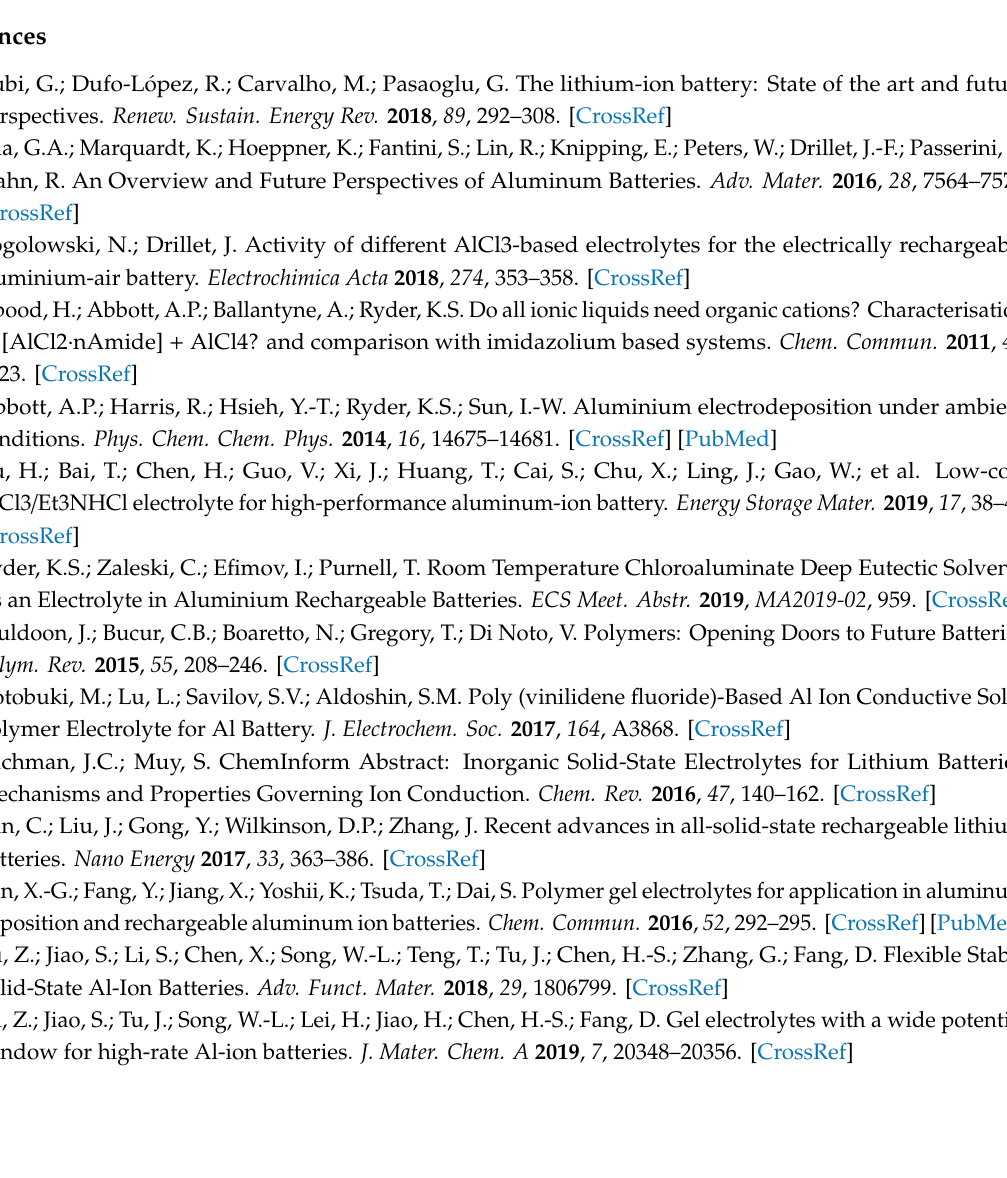
Figure S1: Selected voltagramms from cycle 1 to cycle 100 for ( a ) the less viscous pure U150 and ( b ) the most viscous gel PEO50-5 / U150, showing the steady state from 40 cycles on. ( c ) Evolution on current j at -0.8 V for U150, PEO50-2.5 / U150 and PEO50-5 / from cycle 1 to